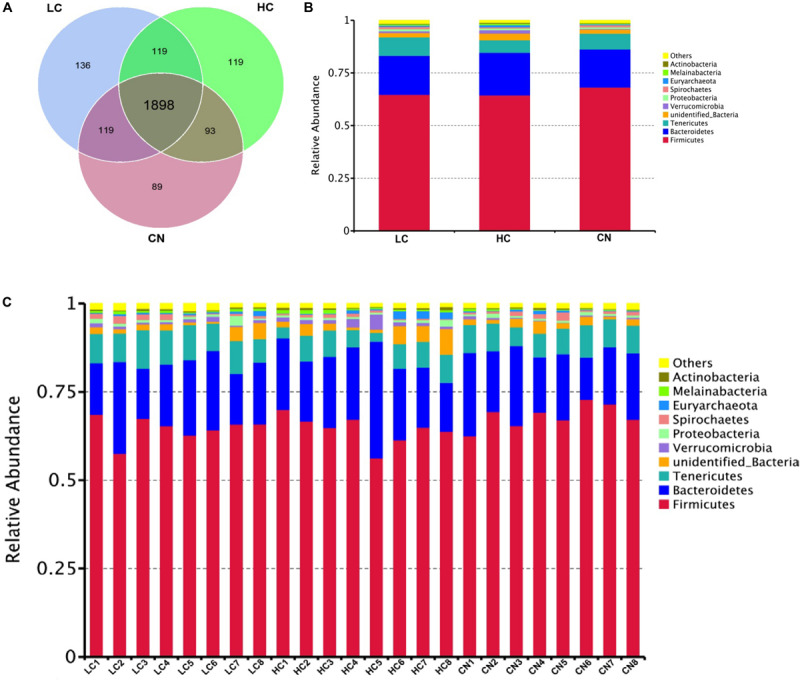
Common and specific OUT distribution of the fecal microbiota among three groups (A); community bar-plots analysis shows relative abundance of fecal microbiota at the phylum level in each group (B) and in each sample (C). CN, no herbal tea residues; LC, 5% fermented HTRs replaced corn silage; HC, 10% fermented HTRs replaced corn silage.